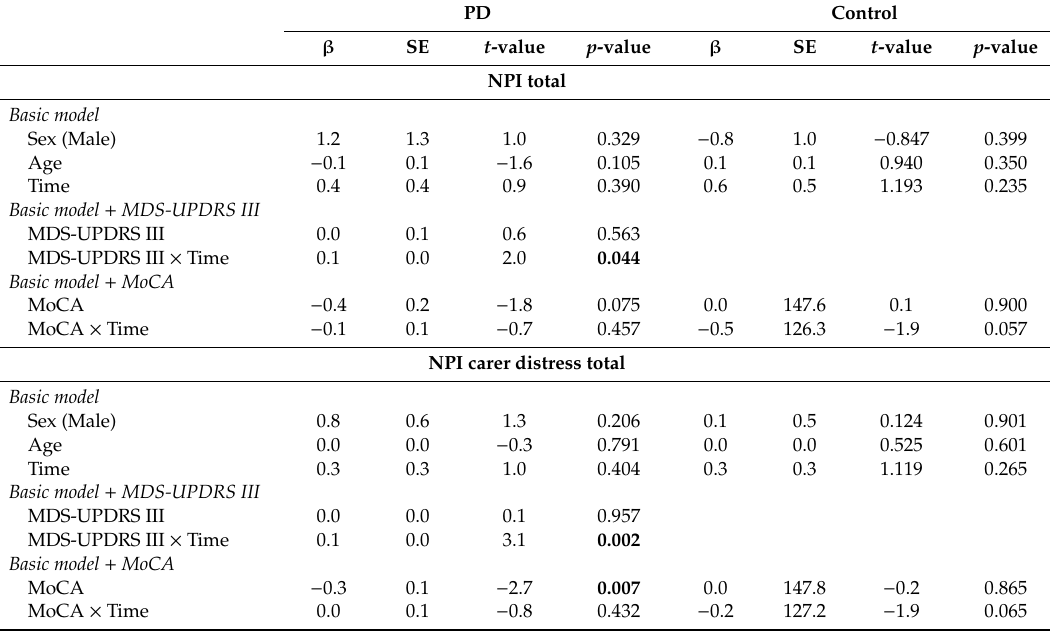
Baseline predictors of change in NPI total and NPI carer distress total using mixed-e ff ects modelling. PD